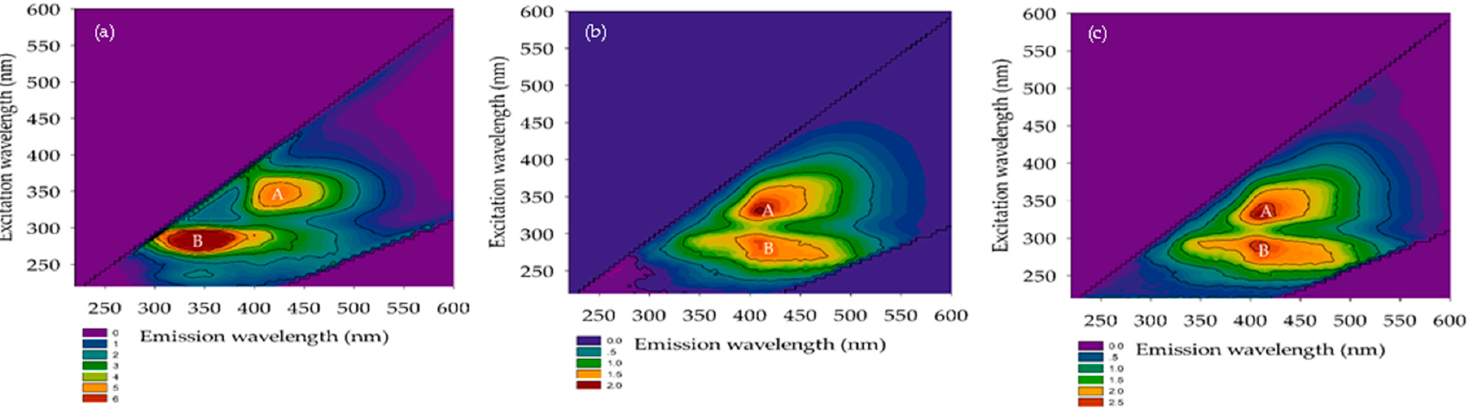
Figure 9. FEEM of the A/O-MBR and O-MBR systems at a SRT of 20 days. ( a ) Raw wastewater. ( b ) Permeate from A/O-MBR (System 1). ( c ) Permeate from O-MBR (System